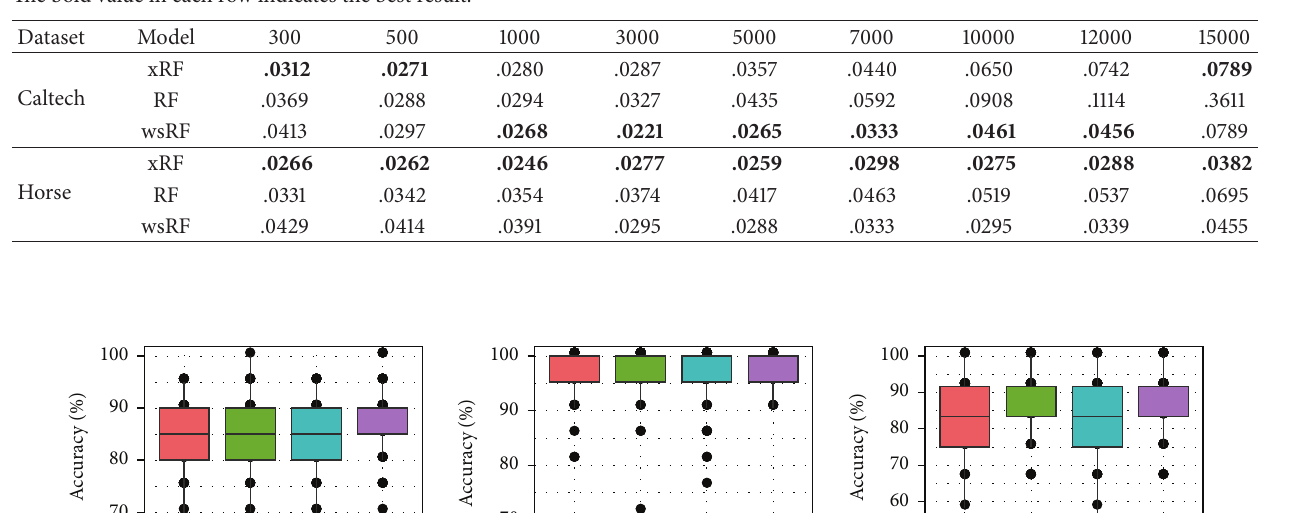
Table 2: The ( 𝑐/𝑠2 ) error bound results of random forest models against the number of codebook size on the Caltech and Horse datasets. The bold value in each row indicates the best result.